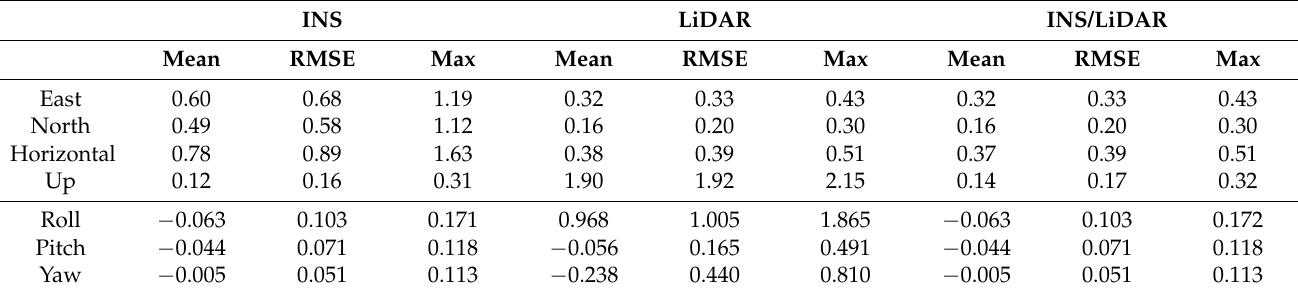
Table A15. D-79—position (m) and attitude (deg) error statistics.